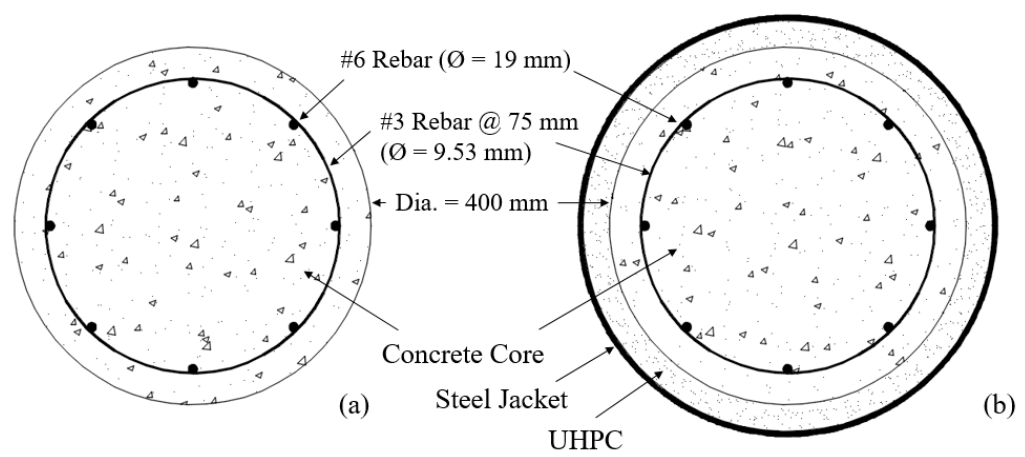
Figure 9. Model configuration ( a ) RC and ( b ) UHPC retrofitting with a steel jacket.